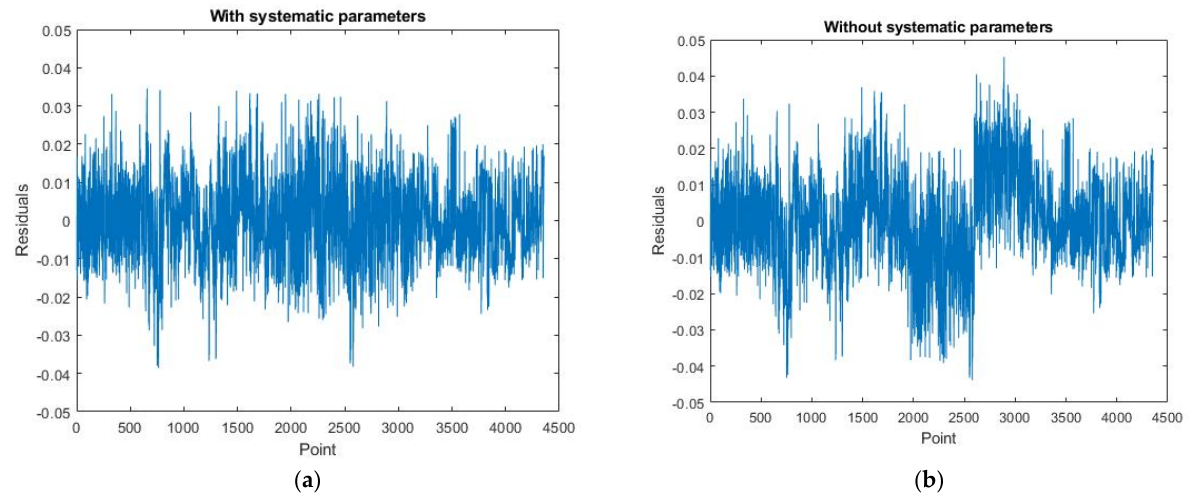
Figure 22. The residual scatter diagram of dataset DATA1. ( a ) with Aps; ( b ) without Aps.